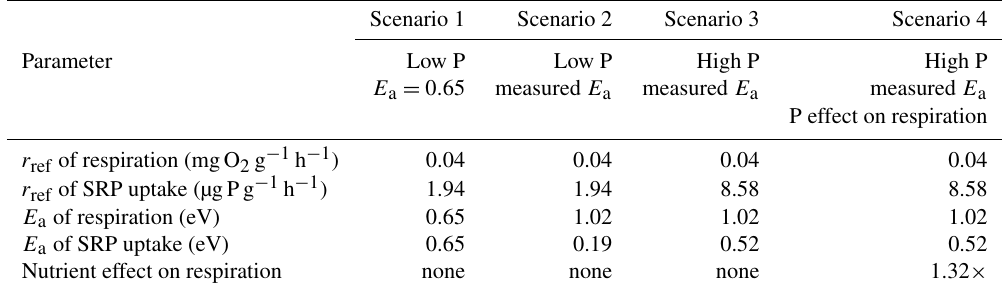
Table 1. Summary of parameters used in different scenarios of simulations models. Reference rates of processes ( r ref ) are presented in units of mass of oxygen per gram of leaf ash-free dry mass per hour at 12 ◦ C. The temperature dependence of processes is represented as the activation energy ( E a ) .